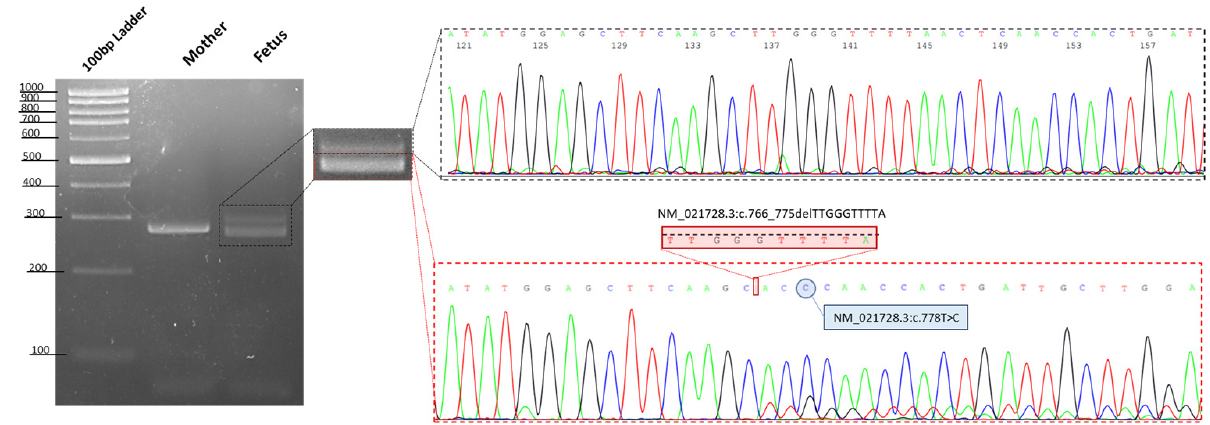
Figure 4. Gel image showing the PCR products of exon 5 of the OTX2 gene. The resultant PCR products using DNA from a control (in this case the mother of fetus), showed a single amplified DNA fragment of 290 bp, as expected of a normal allele, whereas the proband showed two bands comprising an aberrant band (280 bp), that was smaller than that of the mother. Sanger sequencing shows the two different alleles in the proband, highlighting the presence in cis of the two identified variants in the OTX2